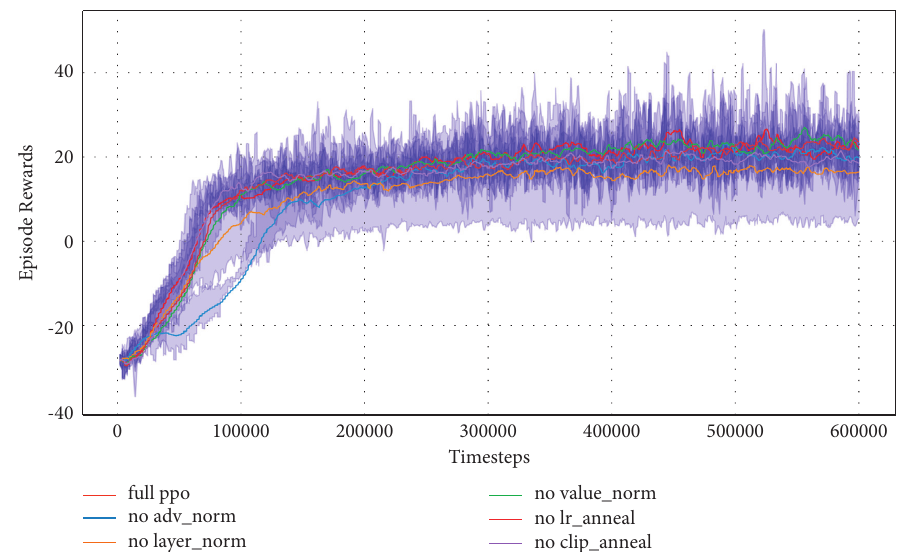
Figure 14: Learning-curve comparison of different